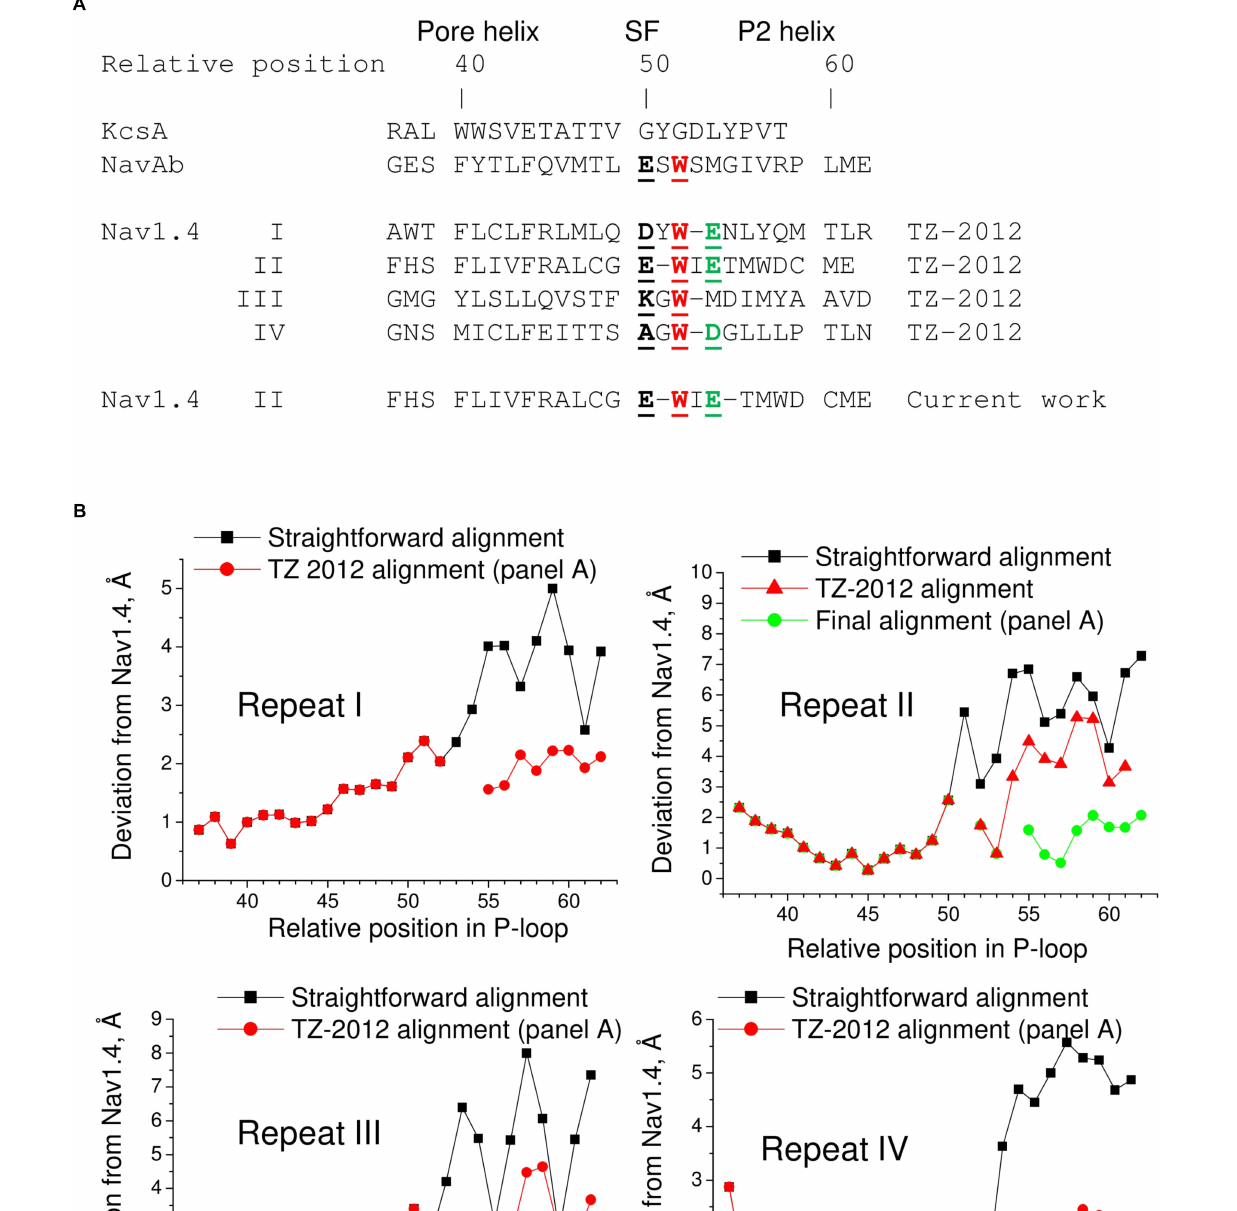
Frontiers in Pharmacology |